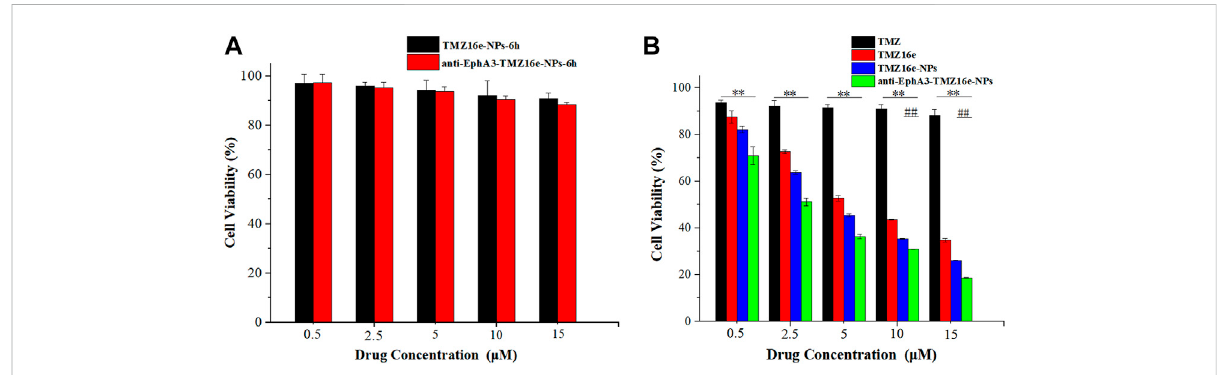
FIGURE 3 (A) Cell viability of 16HBE cells treated with TMZ16e-NPs and anti-EphA3-TMZ16e-NPs for 6 h. (B) Cell viability of T98G cells treated with TMZ, TMZ16e, TMZ16e-NPs, and anti-EphA3-TMZ16e-NPs for 72 h ( n = 3), ** p < 0.01 versus TMZ, ## p < 0.01 versus TMZ16e-NPs.